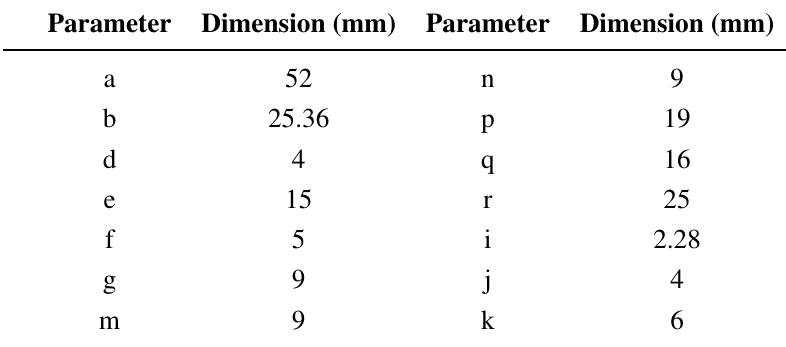
Table 1. Detailed design parameters of proposed SIW resonator.